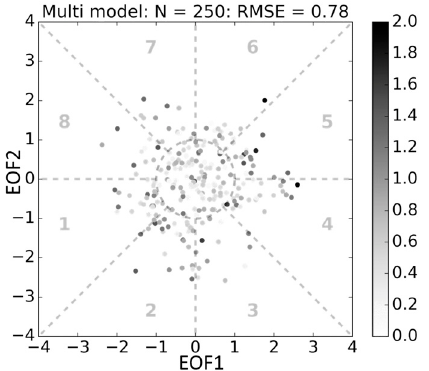
Figure 8. Scatter plot of the prediction skill at the 10-day lead time for each forecast based on the multimodel average. multimodel